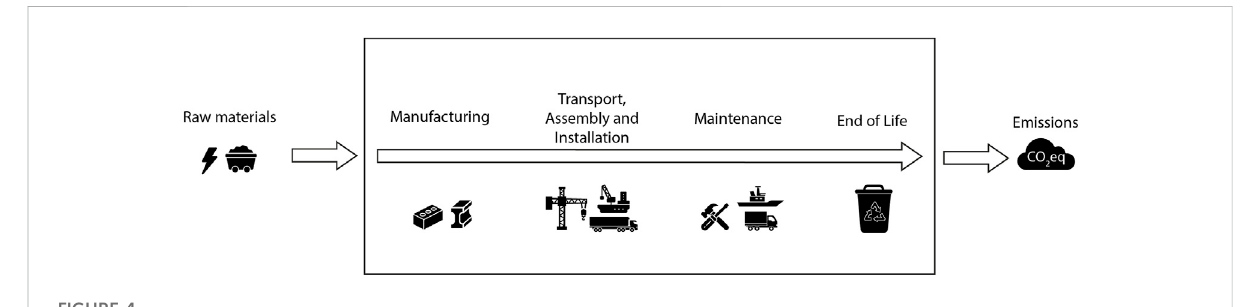
Frontiers in Energy